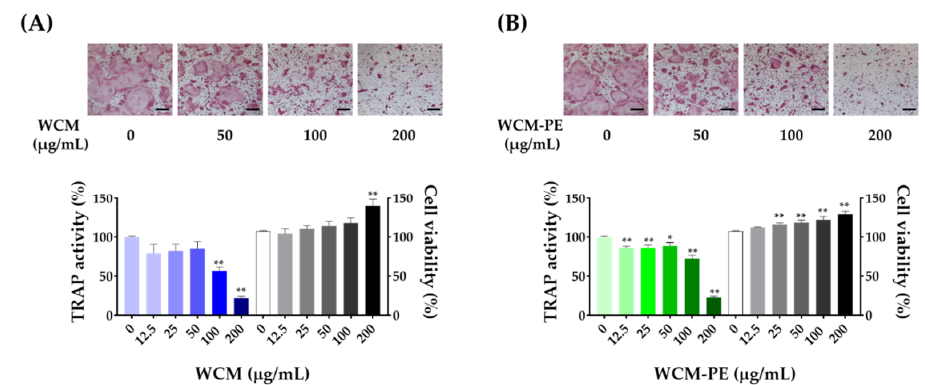
Figure 3. Commiphora myrrha exhibits an anti-osteoclastogenic effect on RANKL-stimulated BMMs regardless of cytotoxicity. ( A ) Water extract of C. myrrha resin (WCM), ( B ) Polysaccharide extract of WCM (WCM-PE). Inhibitory effect of WCM and WCM-PE (0–200 µg/mL) on osteoclast formation under tartrate-resistant acid phosphatase (TRAP) staining. Results are presented as mean ± SEM and analyzed by one-way analysis of variance with Dunnett’s post hoc test. * p < 0.05 versus control. ** p < 0.01 versus control. Scale bar, 100 µm.